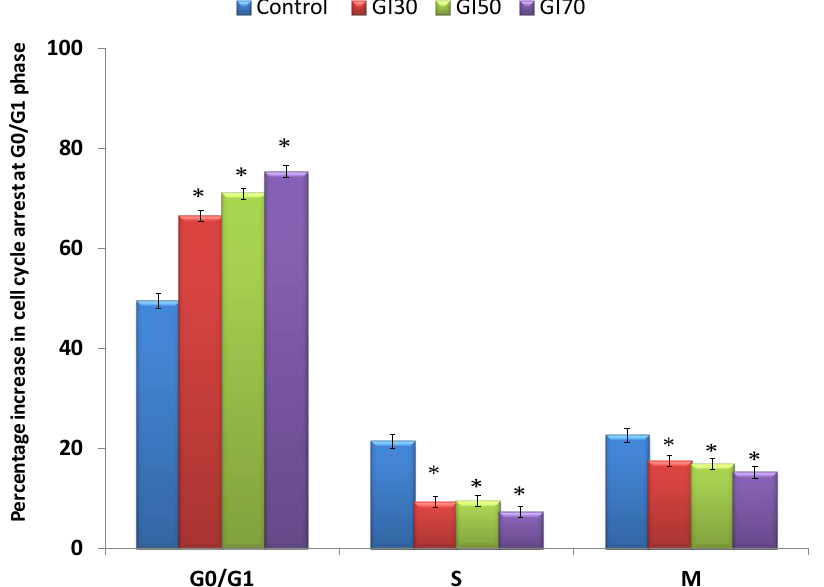
Figure 14. The treatment of Epiafzelechin from C. fistula (24 h) induced cell cycle arrest at the G 0 / G 1 phase in MG-63 cells detected by the cell cycle analysis kit. Ten-thousand events were acquired and the gated cell population analyzed using flow cytometry. * indicates a statistically significant difference at ( p ≤